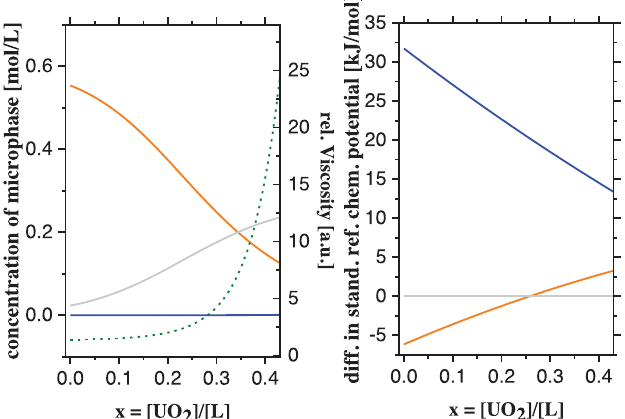
Fig. 13. Left: evolution of the microphase distribution and simulated viscosity as a function of the uranyl concentration. Right: difference in standard reference chemical potential respective to cylinders as reference state. Color code: orange: endcaps, grey: cylinders, blue: junctions, black experimental values. For this example, the following input parameters were used: P 0 ( x =0) =2.8; P 0 ( x = 0.43)=2.2; c (Ex)=1.2 M; k * =2